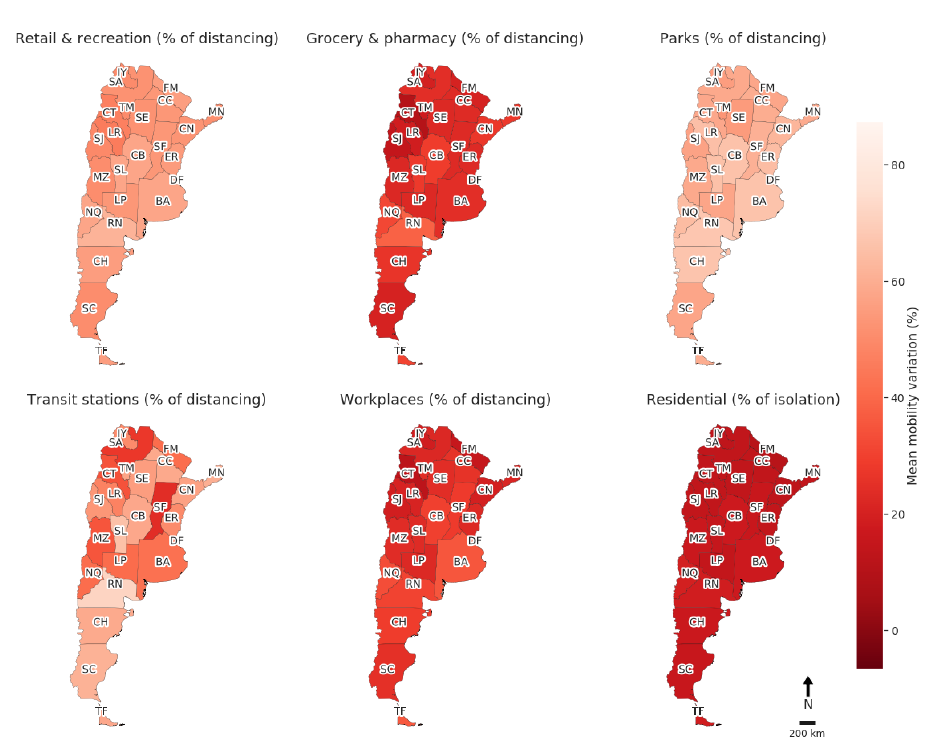
Figure 13. Average variation of mobility from baseline (3 January to 6 February 2020) for the provinces of Argentina during the period from 15 February to 31 May 2020. Lighter colours indicate greater distancing or greater isolation in residential areas. Source of basic data: Covid-19 Community Mobility Reports, Google.